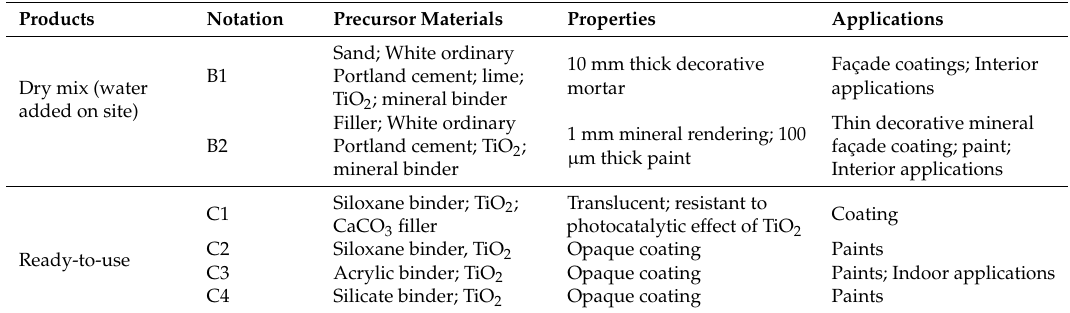
Table 8. Preparations and properties of the range of water-based products developed within the PICADA